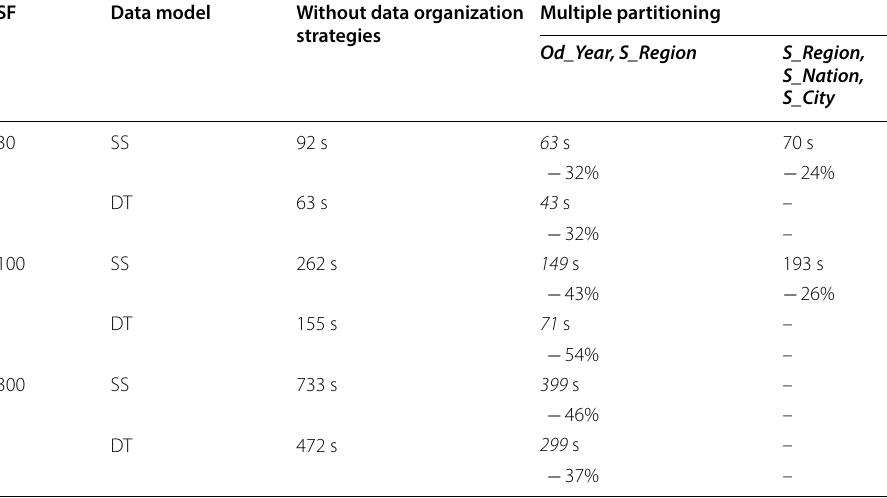
Italic values indicate the fastest processing time by SF, data model and